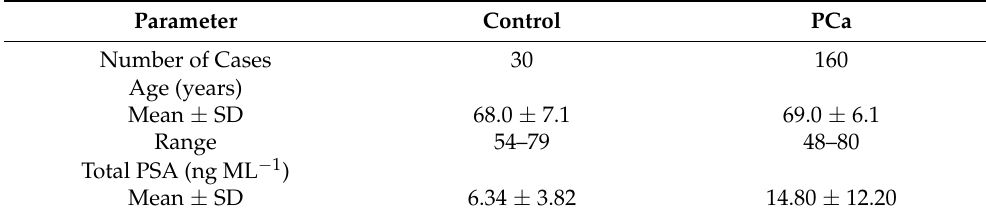
Table 4. Characteristic of groups in reference to morphological evaluation according to pTNM stage assessment characteristic of population in the two groups. PCa = prostate cancer cases and BPH = benign prostatic